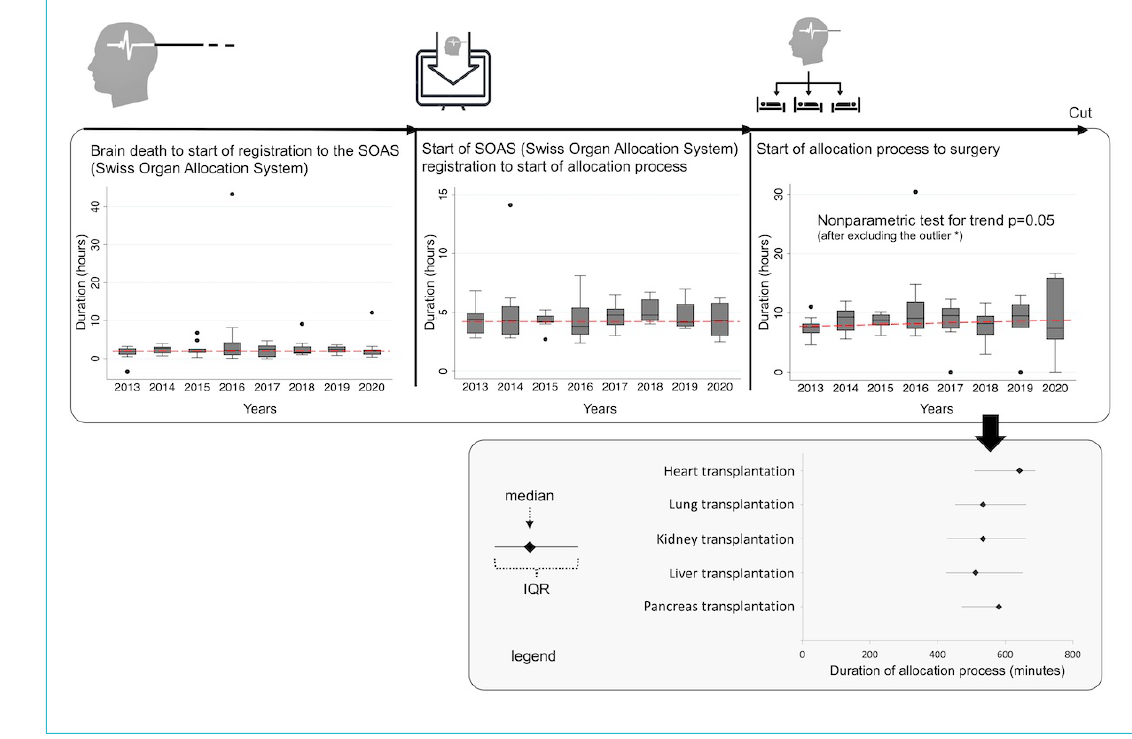
Figure 2: Duration of specific post-mortem procedures to surgery over the study period. IQR: interquartile